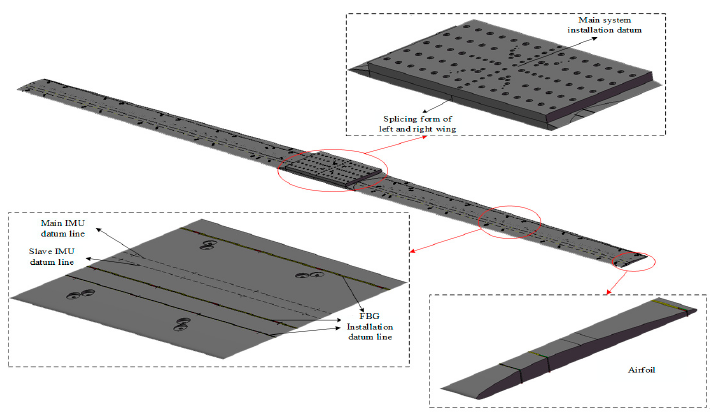
Figure 10. Simulation of wing structure.